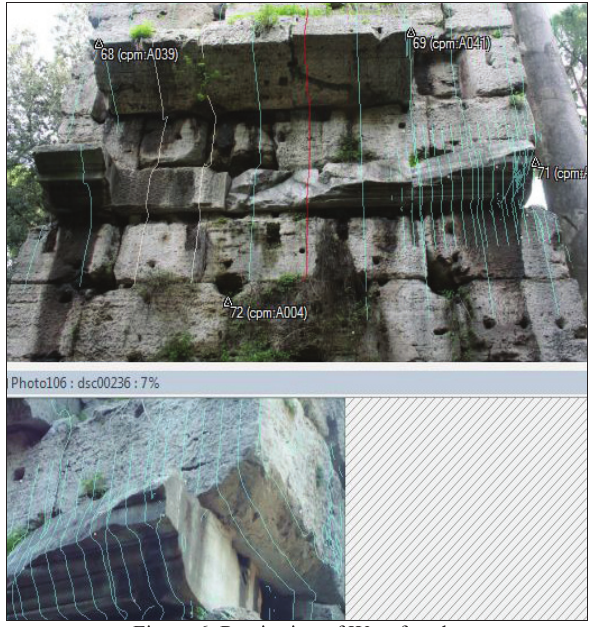
Figure 7. Restitution of West façade: superimpotion of survey model and represented model